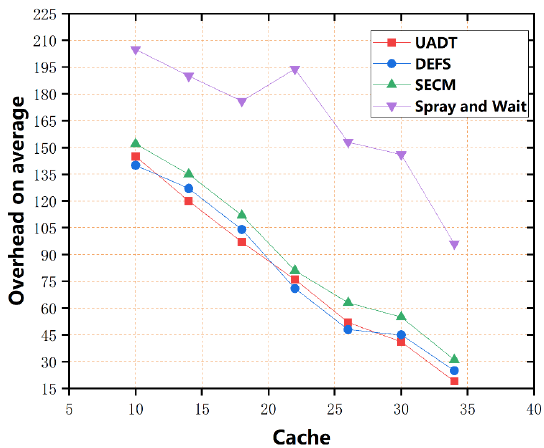
Figure 5. Relationship between overhead on average and cache.